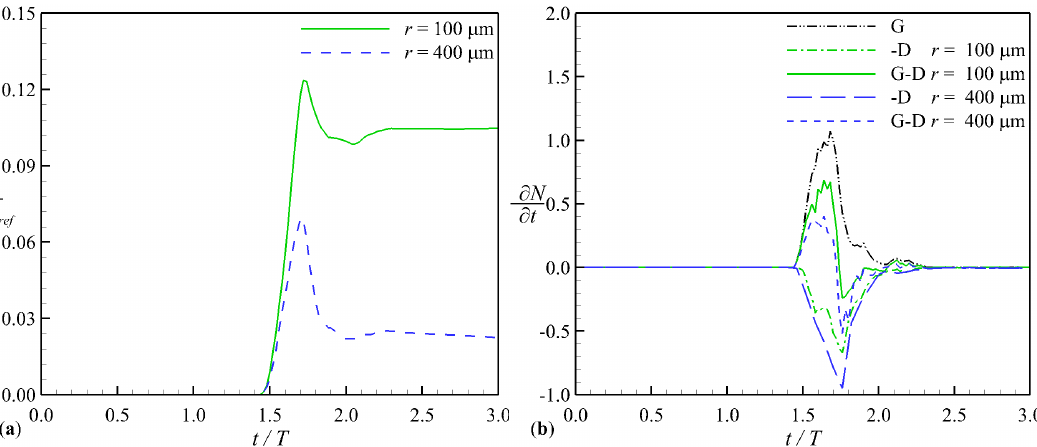
Figure 6. Time histories of ( a ) the number of droplets N / N ref , and ( b ) generation rate GT / N ref and disappearance rate − DT / N ref of droplets in Case